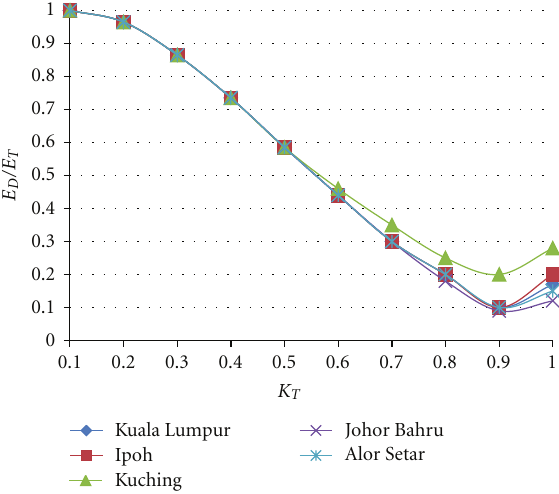
Figure 3: Regression curves of daily di ff use ratio—Malaysia.